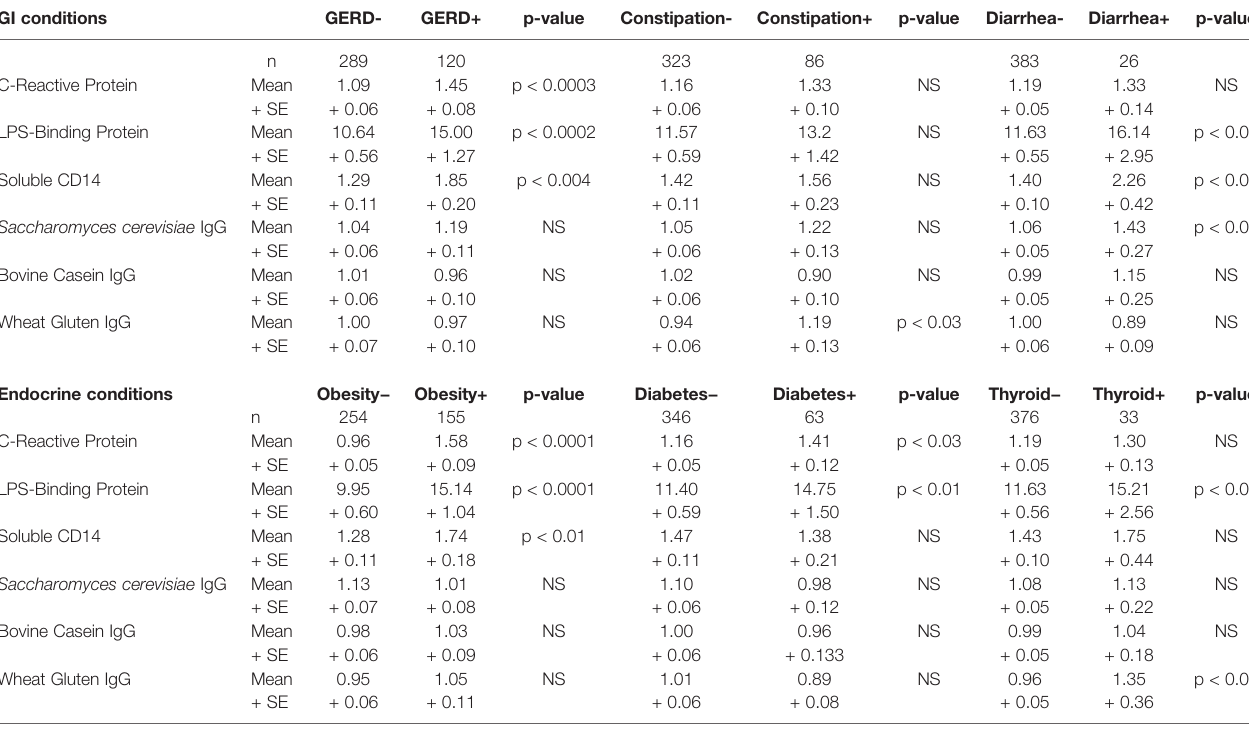
TABLE 4 | Associations of biomarkers with speci fi c GI and endocrine conditions. GI conditions